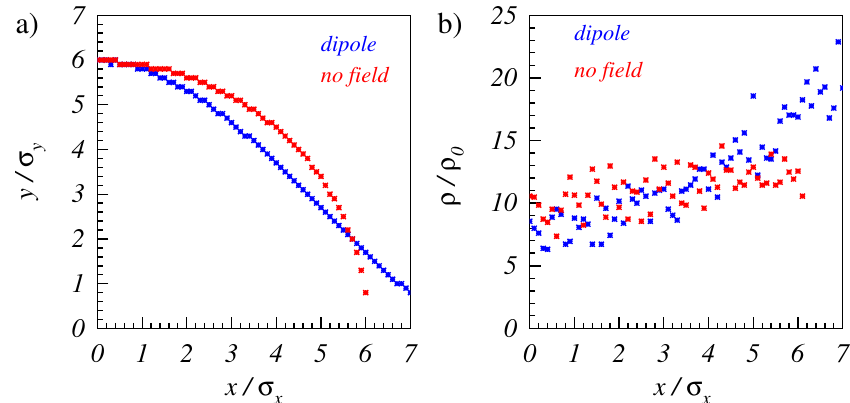
INCOHERENT EFFECT OF SPACE CHARGE AND . .